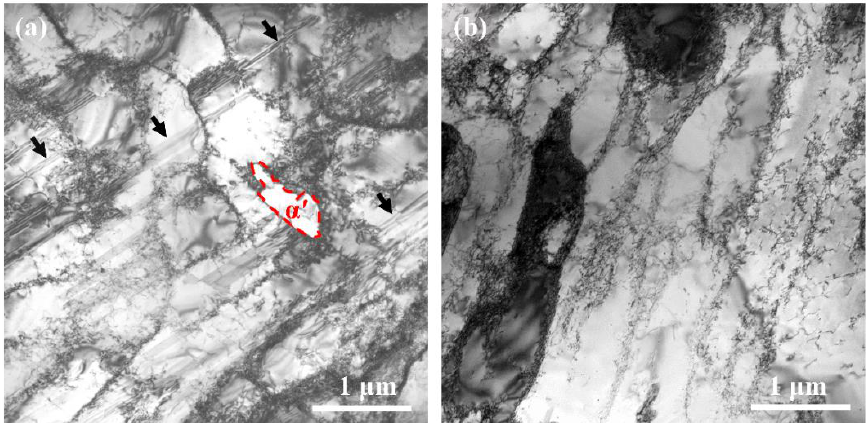
Figure 8. Typical TEM morphologies in the sample interior of ( a ) the SMRT-100 and ( b ) the SMRT-280 samples fatigued at a strain amplitude of 0.50%. α (cid:48) -martensite (as labeled) and stacking faults (as pointed by arrows) were observed in ( a ).